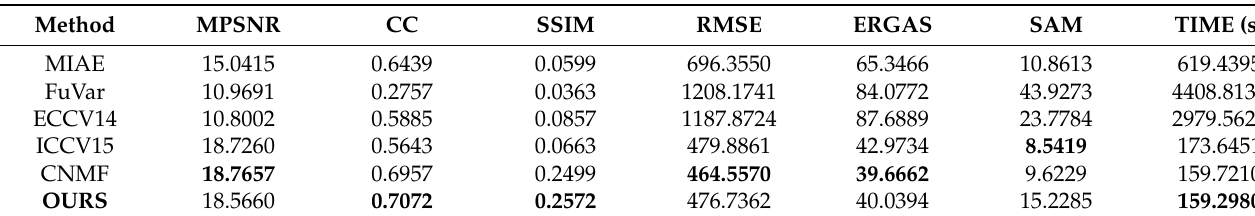
Table 4. Quantitative indices of SRR in ZY-1 02D HSI before denoising.